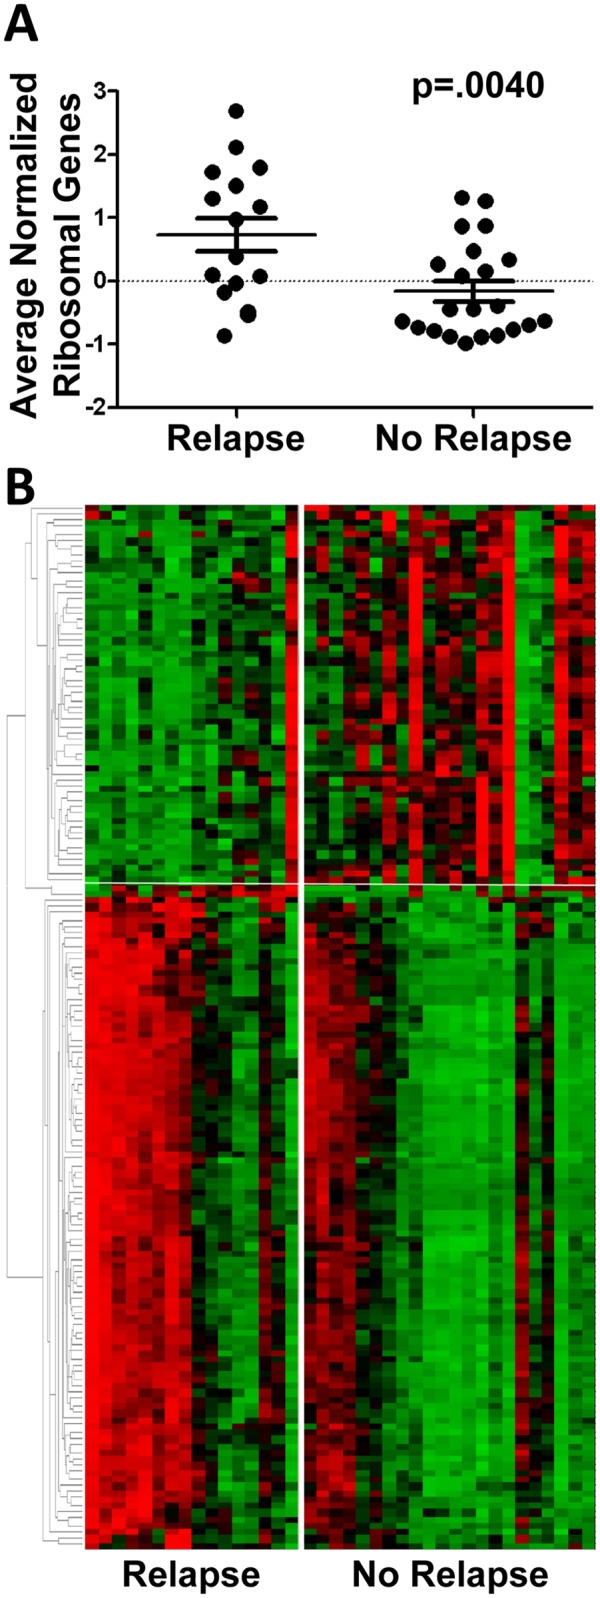
Direct comparison of gene expression of peripheral blood samples between patients with or without a history of relapse.(A) Average normalized ribosomal gene signature expression values in patients with or without a history of relapse. Error bars depict standard error of the mean. Expression values were compared using Student’s t-test. (B) Relative expression levels of genes differentially expressed between relapse and non-relapse patients presented following clustering. Colors indicate relative increased (red) or decreased (green) expression.